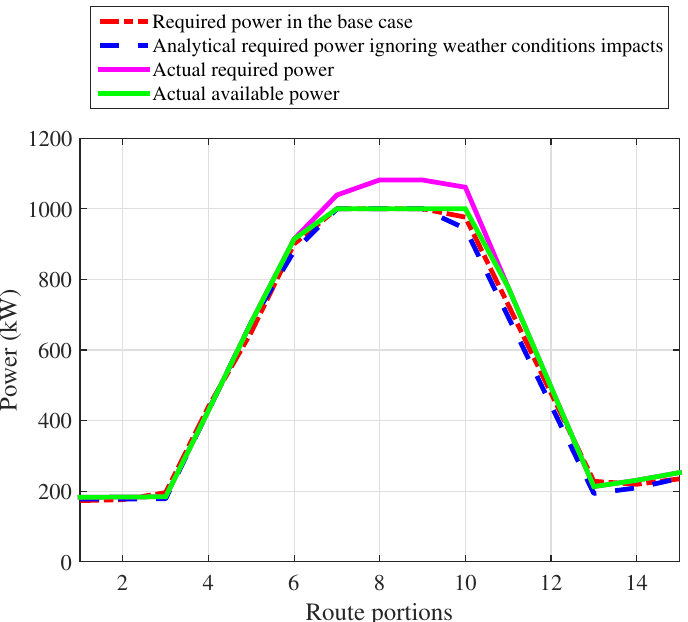
Figure 12. Comparing the output power of the diesel generator with and without considering the impacts of weather